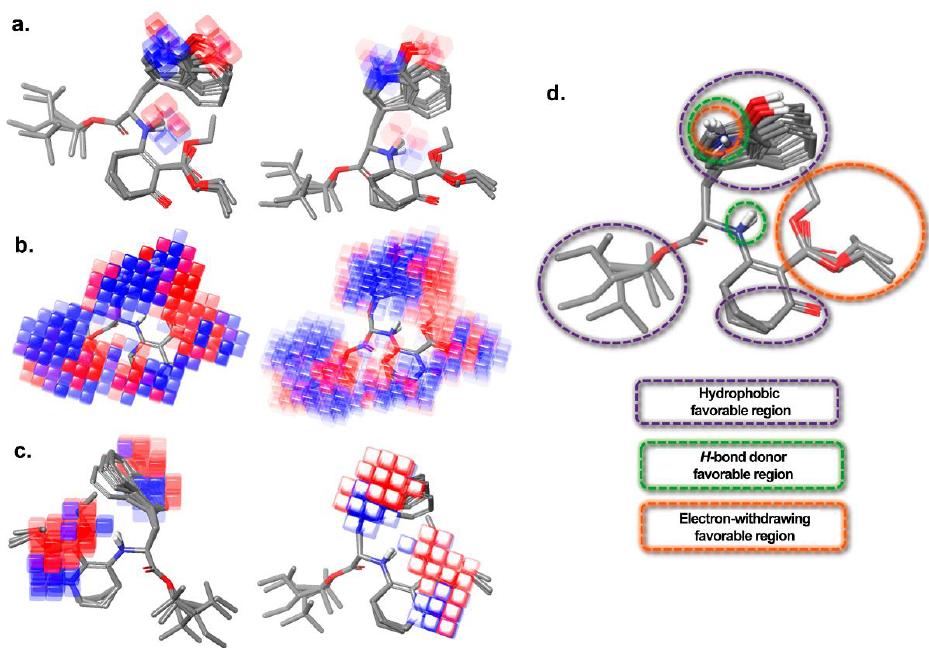
Figure 2. Contours generated by the 3D-QSAR model based on atoms (atom-based approach) after aligning the enamine-type Schiff bases 1 – 48 under the three atom-based categories: ( a ) H -bond do- nors; ( b ) hydrophobic character; ( c ) electron-withdrawing character. ( d ) Global representation